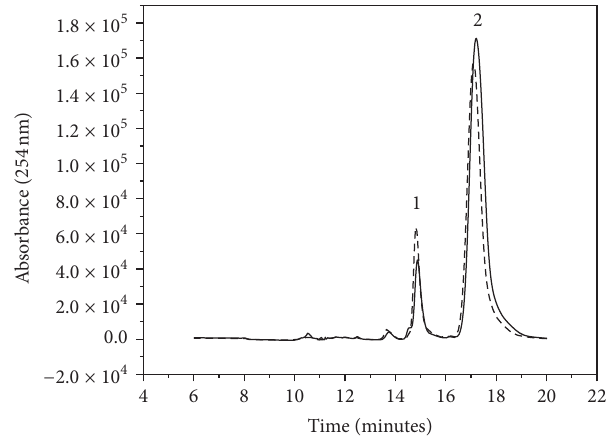
Figure 6: Representative chromatogram of the reduction in the activity of Tc NTPDase-1-ICER in the presence of 100 𝜇 mol ⋅ L −1 Suramin (—). Representative chromatogram in the absence of Suramin (---). Chromatographic conditions as described in Table